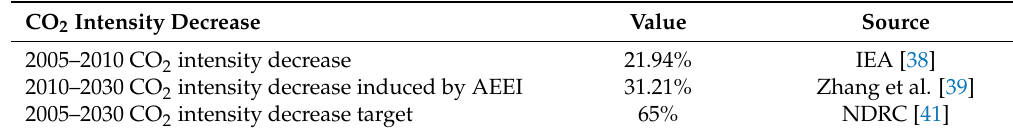
Table 2. Data of CO 2 intensity in